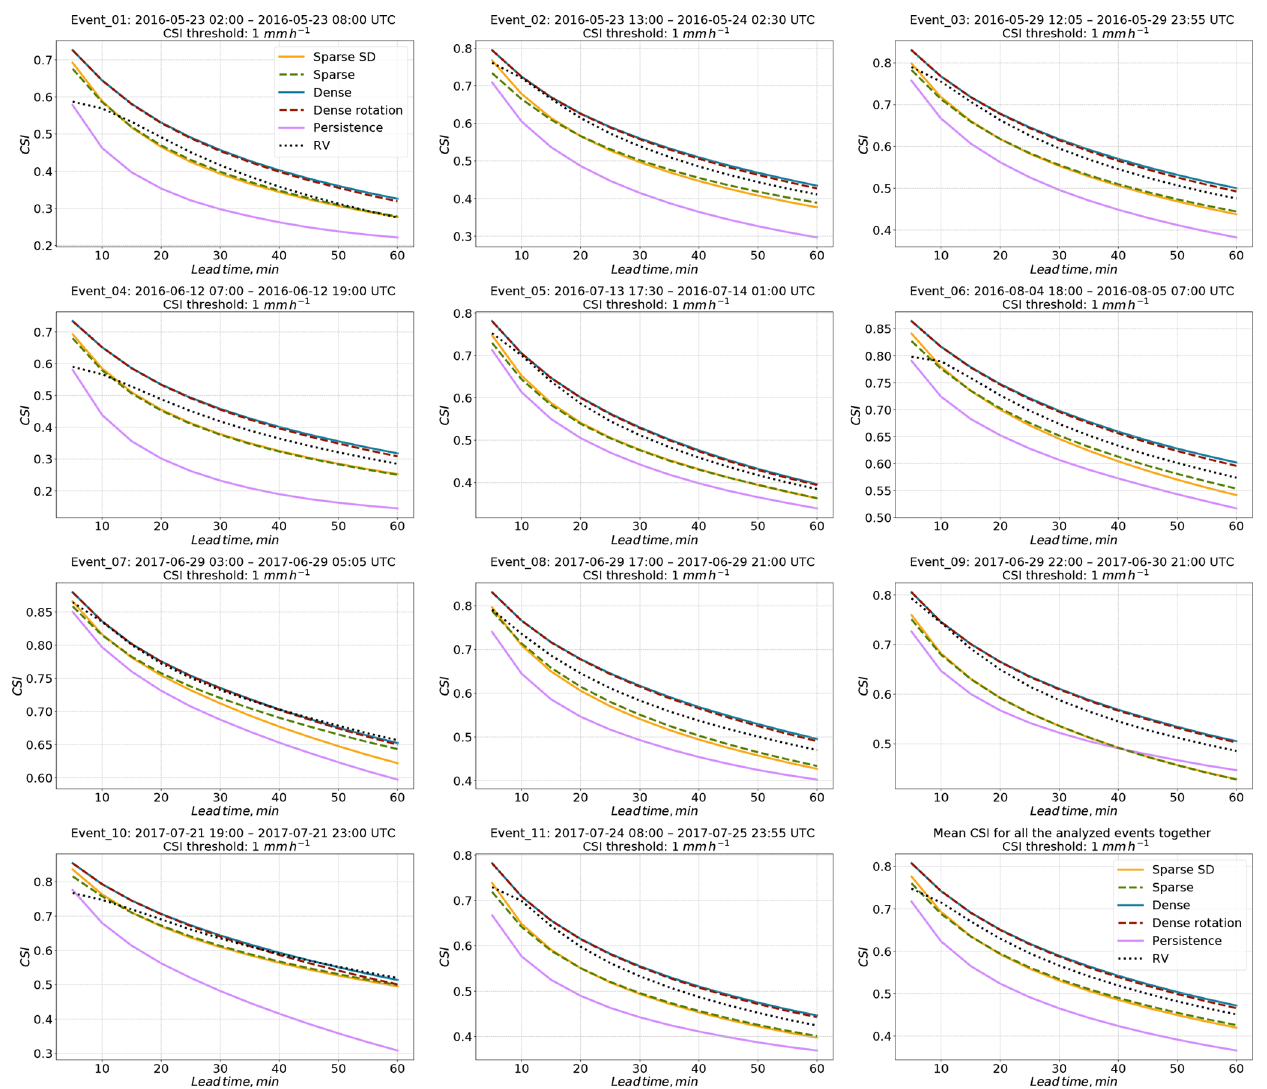
Figure 7. Verification of the different optical flow based nowcasts in terms of CSI for the threshold of 1mmh − 1 for 11 precipitation events over